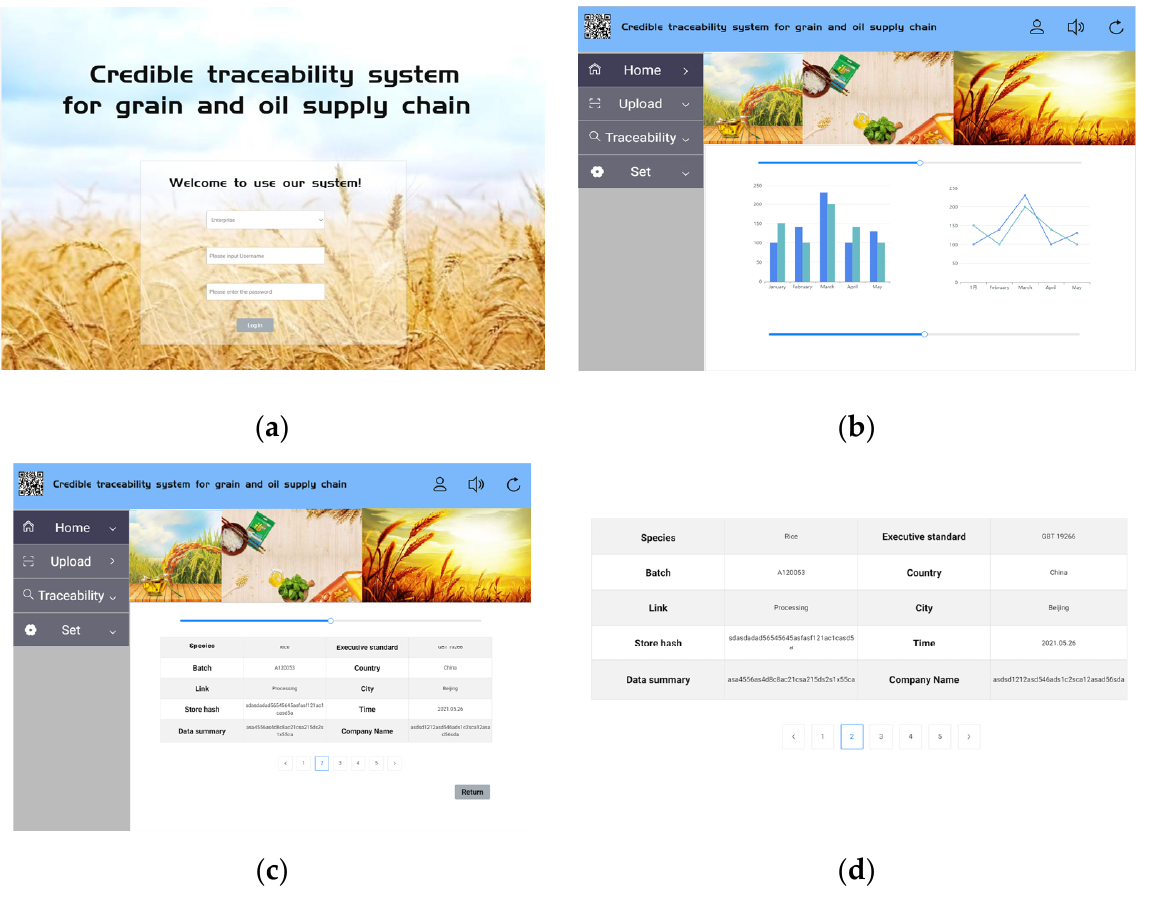
Figure 9. Schematic diagram of the prototype system interface. ( a ) Shows the login interface of the system, the user selects the corresponding category to log in to the system to obtain permissions; ( b ) shows the main interface of the system, the main interface consists of two departments, and the top is the advertisement carousel of the merchants, and the bottom part shows the recent system login times and the number of rice batches that have been attacked recently; ( c ) shows the enterprise uploading relevant data interface, including grain and oil types, batches, links, company name, time, data summary and other information; ( d ) displays the traceability information of the corresponding supply chain link of the product.